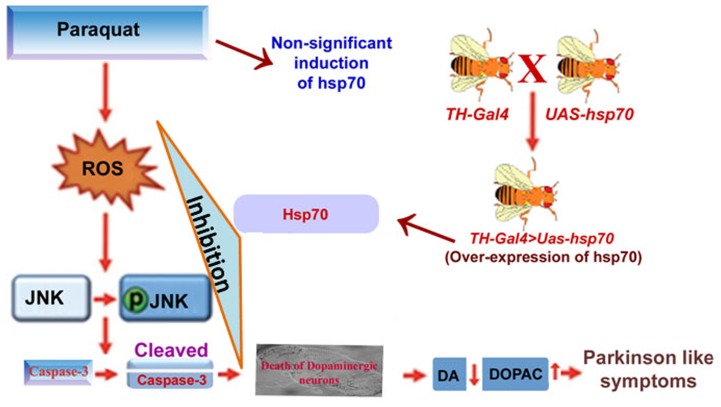
Schematic representation of the neuro-protective role of Hsp70 against PQ-induced PD like symptoms.PQ-induced ROS generation led to the activation of JNK and caspase-3, which eventually caused death of the dopaminergic neurons and induces PD like symptoms in the exposed organism. The observed PD like symptoms was resisted by over-expression of one of the key chaperons, Hsp70, in the dopaminergic neurons of Drosophila. Hsp70 inhibits PQ-induced activation of JNK and caspase-3 mediated neuronal cell death, thereby providing protection to the organism.